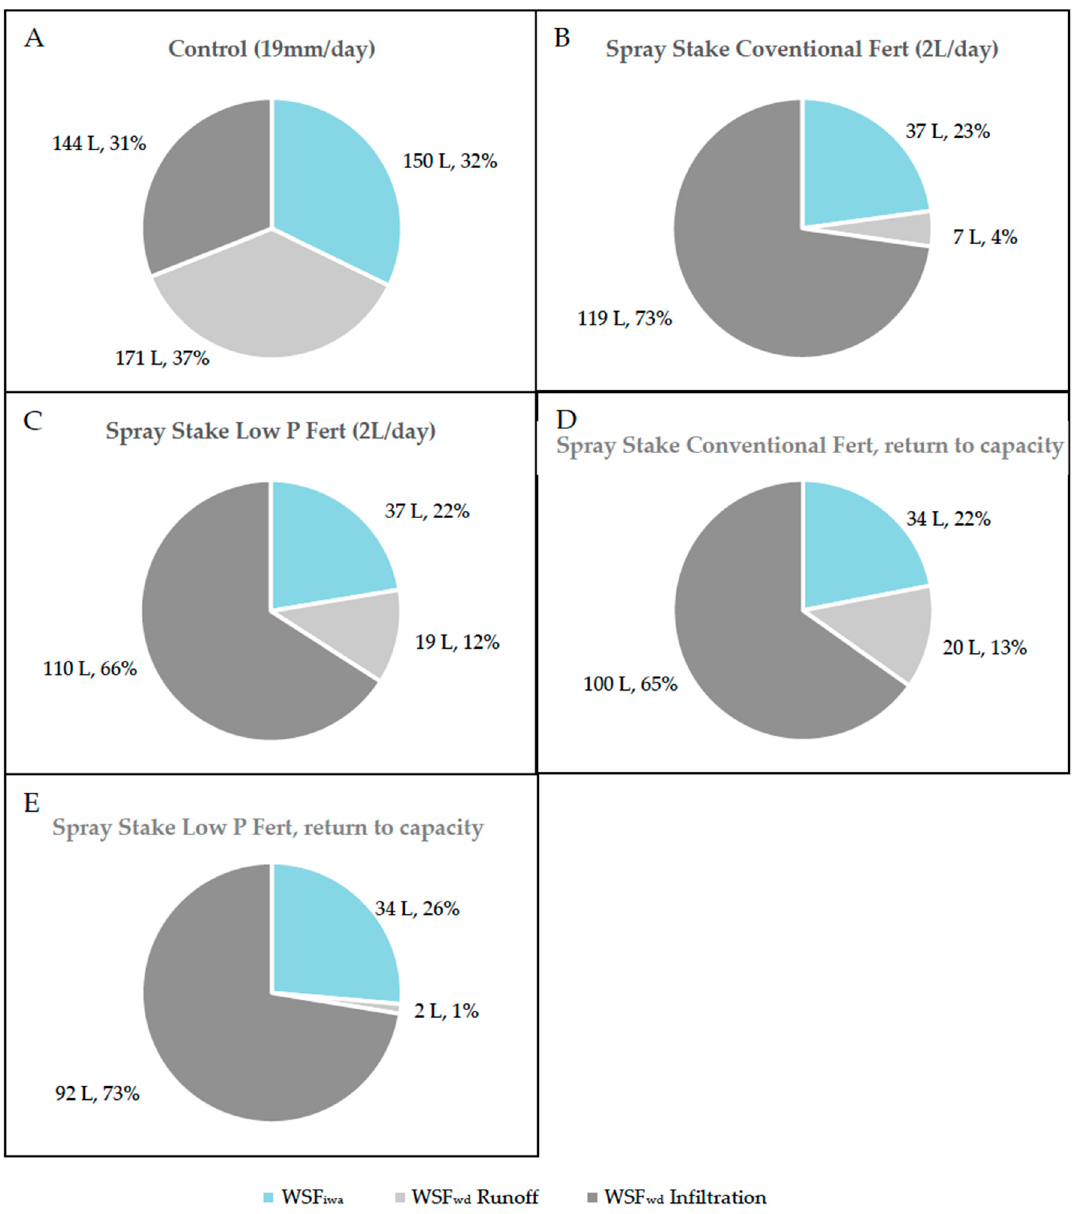
Figure 7. The relative contributions of water scarcity footprint of irrigation water applied (WSF iwa ) and water scarcity footprint of water to meet dilution requirements (WSF wd ) from runo ff and infiltration on the total WSF of woody plants grown in 10.2 L containers for data collected in May through September 2017, under five irrigation regimens ( A – E ) in a model research nursery in